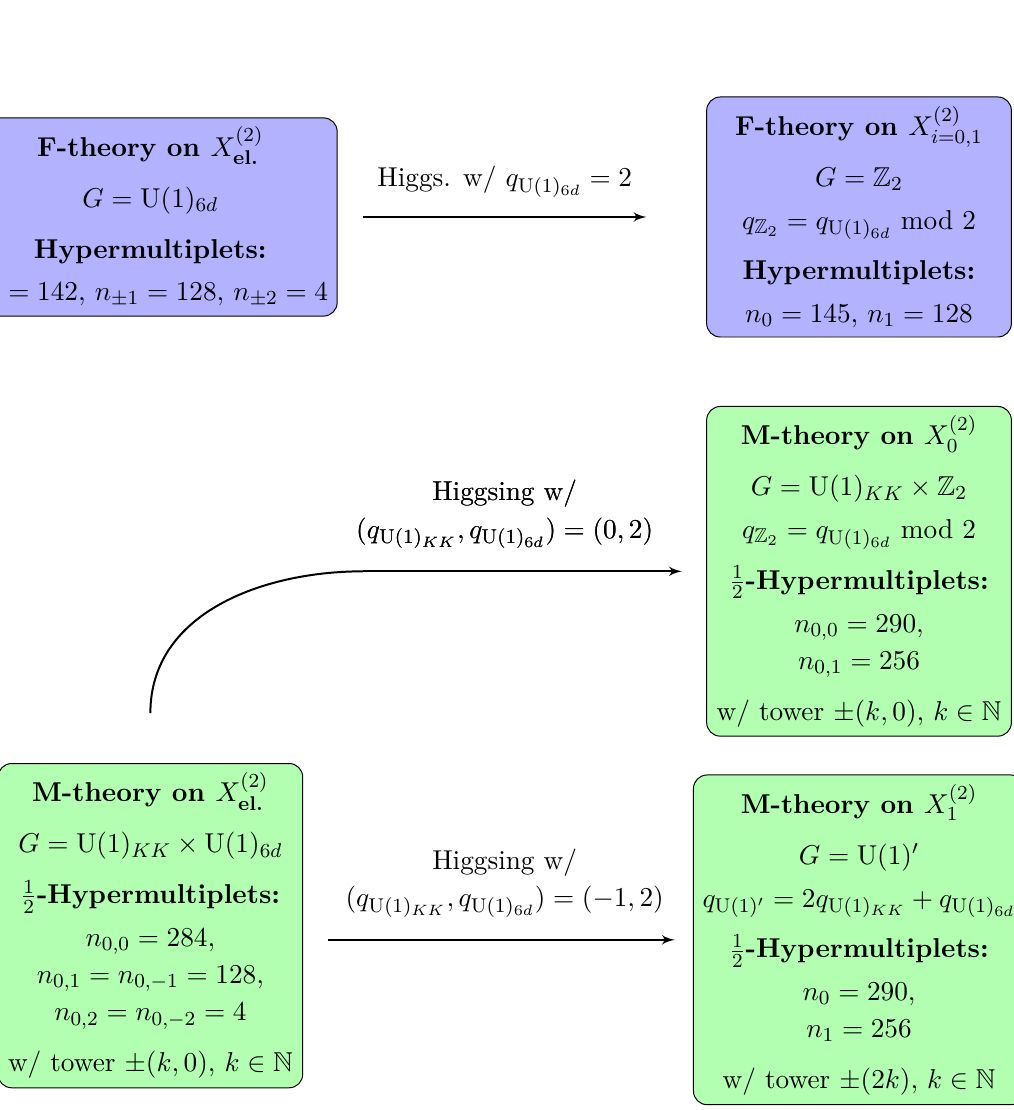
Figure 7 . The six- and five-dimensional gauge groups and matter spectra of F- and M-theory compactifications on X (2) and X (2) , as well as the relations via Higgs i =0 , 1 el.